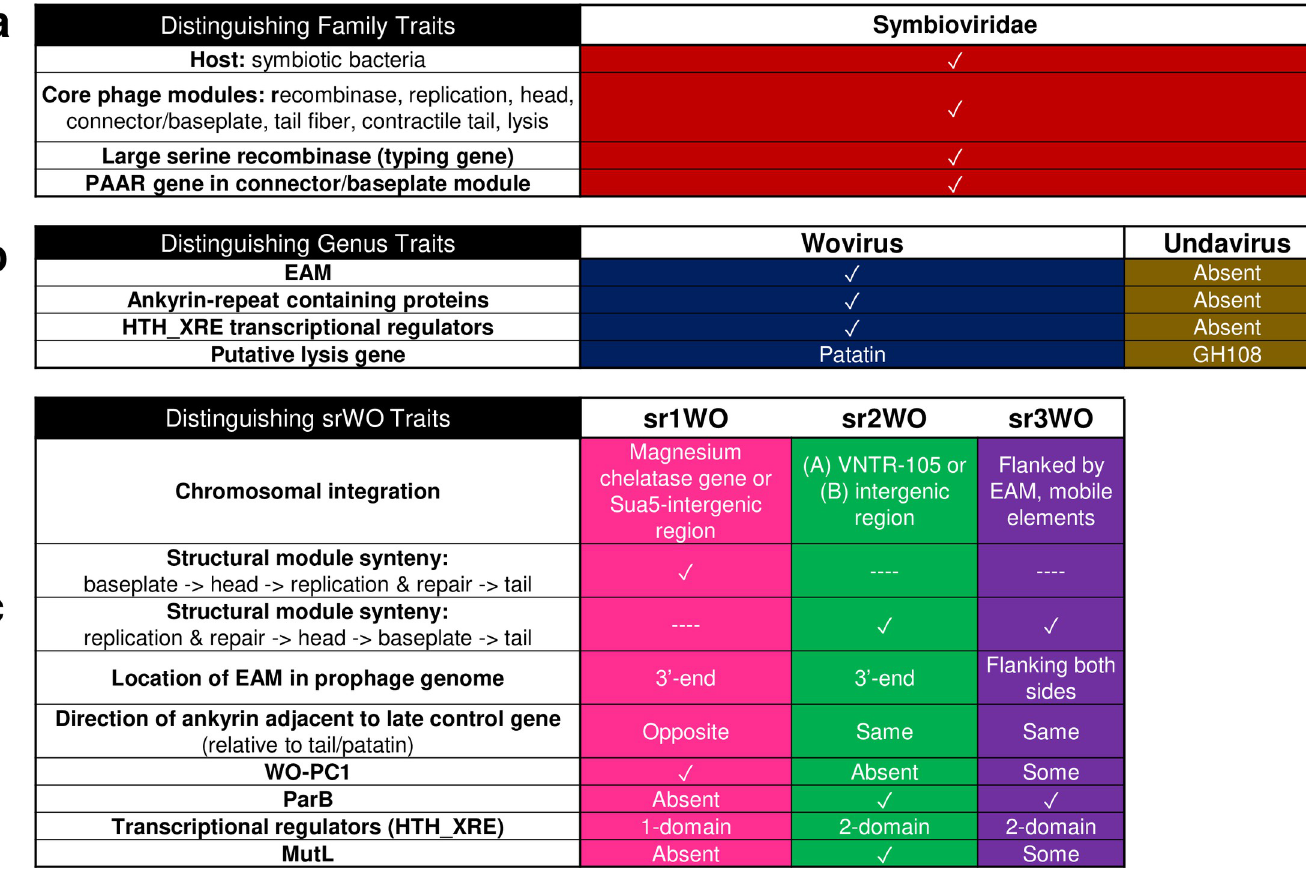
Fig 8. Linnaean classification of prophage WO-like viruses is supported by taxonomic traits at the family and genus level. (a) Proposed family Symbioviridae encompasses viruses that infect symbiotic bacteria, contain a large serine recombinase for integration and a Proline-Alanine-Alanine-aRginine repeat (PAAR) gene in the connector/baseplate module, and feature a conserved set of core phage modules. They share nucleotide homology to Wolbachia ’s prophages. (b) Genera are distinguished by presence (Wovirus) or absence (Undavirus) of an EAM and ankyrin repeat containing proteins. Woviruses may utilize patatin for lysis whereas undaviruses encode a canonical GH108 endolysin. (c) Proposed Wovirus clades are further distinguished by multiple factors including structural module synteny, HTH_XRE domains, and genome